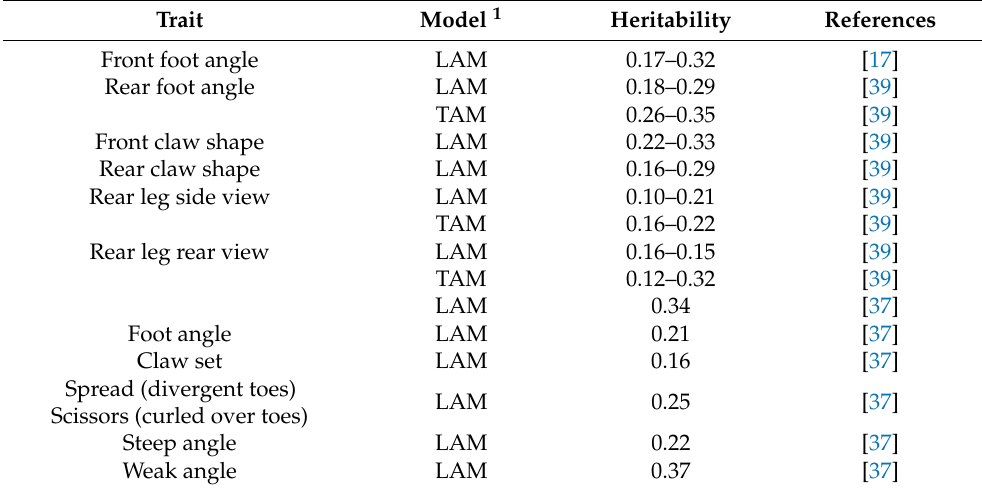
Table 1. Compilation of heritability estimates of various foot and leg structural traits in Angus cattle from Hahn [15], Jeyaruban [39], and Wang